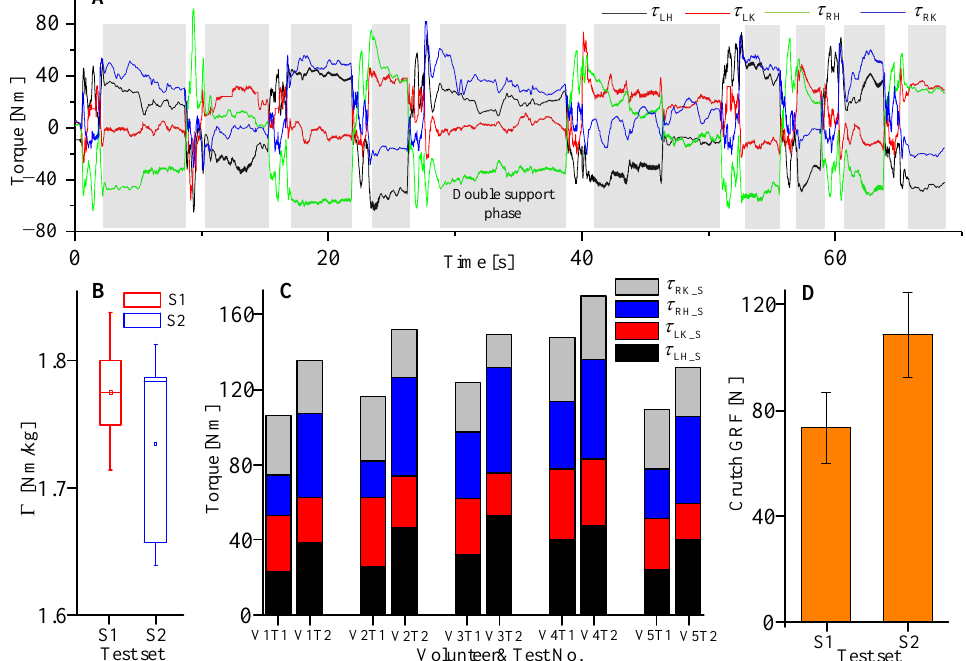
Figure 13. Experimental results of 2 walking test sets. ( A ) Driven torques of 4 joints during one 10-step walking trial. τ LH , τ LK , τ RH , and τ RK are the torques of the left hip, left knee, right hip, and right knee, respectively. ( B ) Box plot of the normalized sum of 4 joint torques during the swing phase based on 5 volunteers’ trials. S1 and S2 denote test set 1 (walking trials with online gait planning based on the combined CoP) and test set 2 (walking trials with fixed reference gait), respectively. ( C ) Comparison of joint torques during the double support phase. τ LH_S , τ LK_S , τ RH_S , and τ RK_S are torques of the left hip, left knee, right hip, and right knee during the double support phase, respectively. ( D ) Average L / R crutches GRFs measured after each swing phase. For each test set, L / R crutches GRFs of each step were measured and averaged based on 5 volunteers’ walking tests.